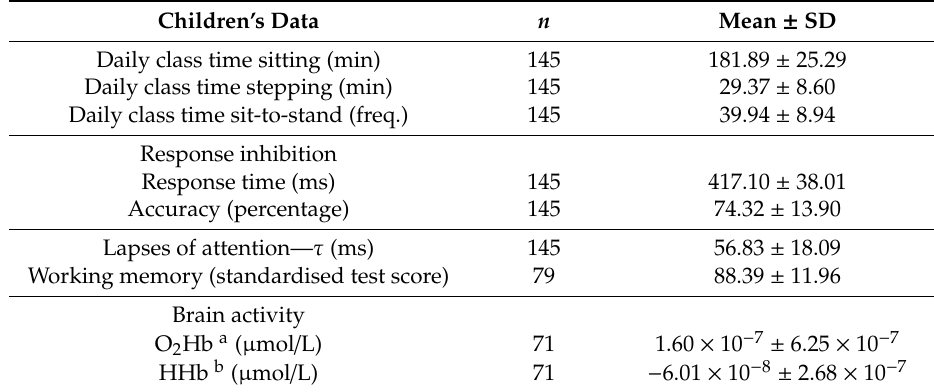
Table 2. Summary statistics (mean ± standard deviation) of daily class time sitting / stepping and sit-to-stand transitions, response inhibition, lapses of attention, working memory and brain